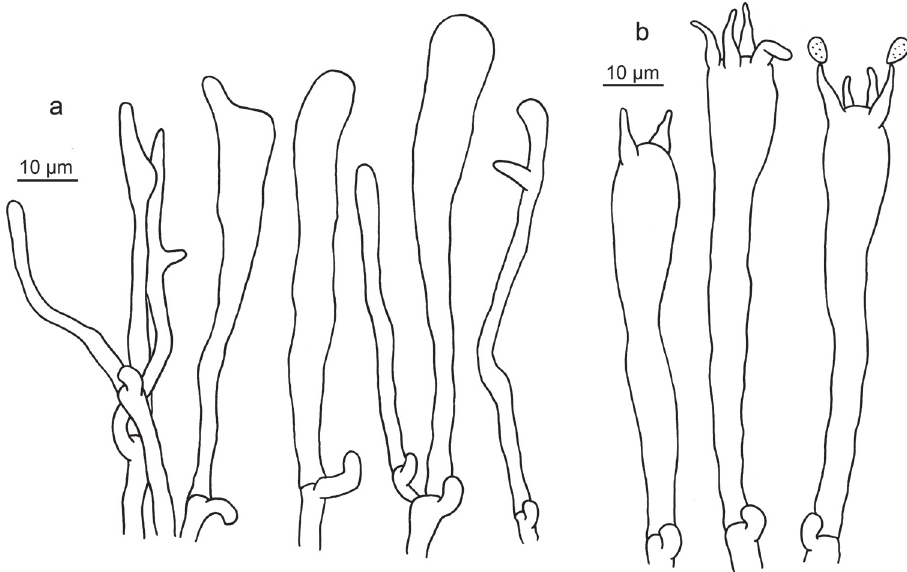
Figure 10. Microscopic features of Clavariadelphus himalayensis (HKAS 58811). a Leptocystidia and immature basidia b